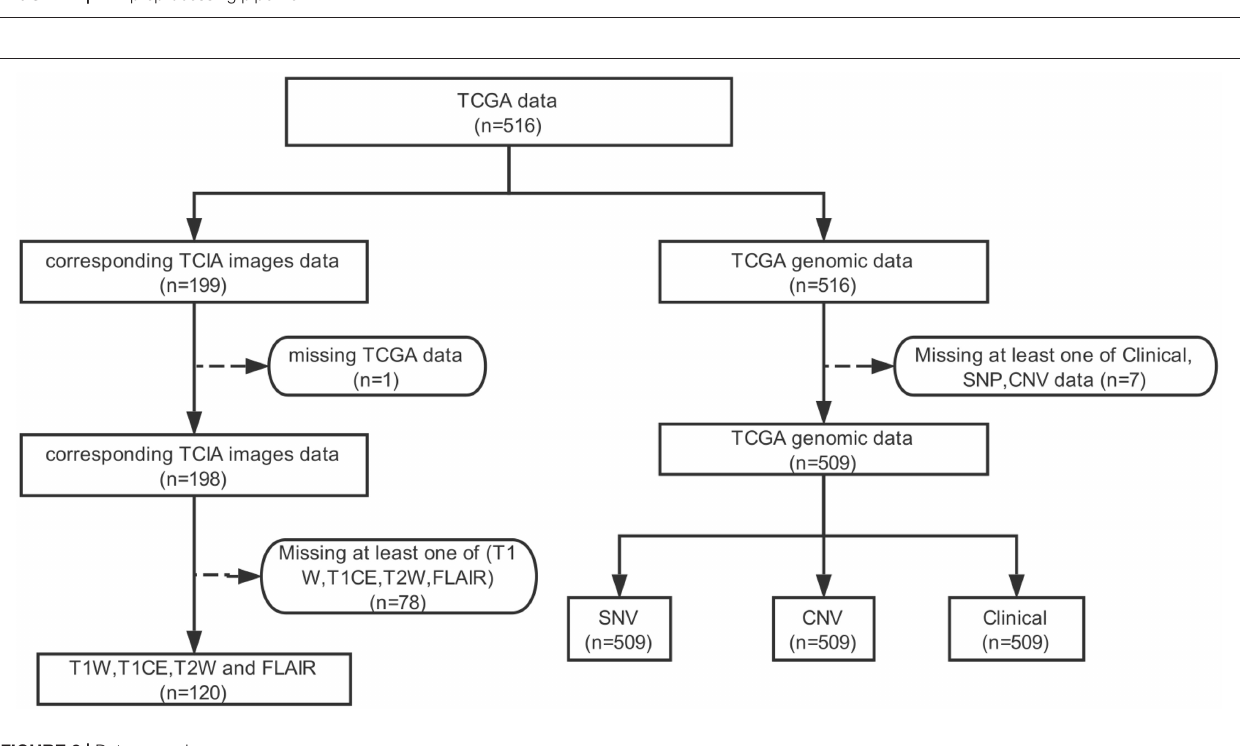
FIGURE 1 | MRI preprocessing pipeline.